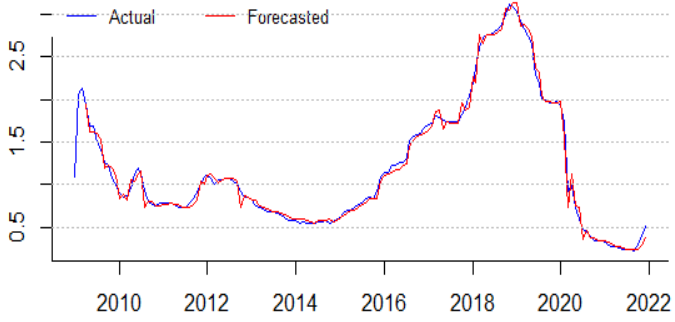
Figure 18. Actual vs. forecasting of the coupon rate using FTSS The forecasting results in Figure 18 show that the curve of the forecasting coupon rate is similar to the actual curve, with a MSE of 0.4%. This shows that the forecasting